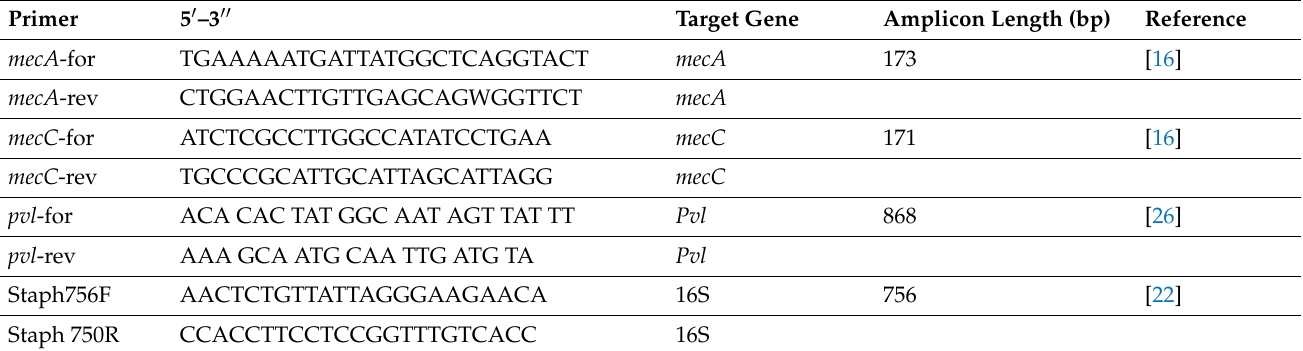
Table 1. Nucleotide sequences and sizes of PCR products of amplified